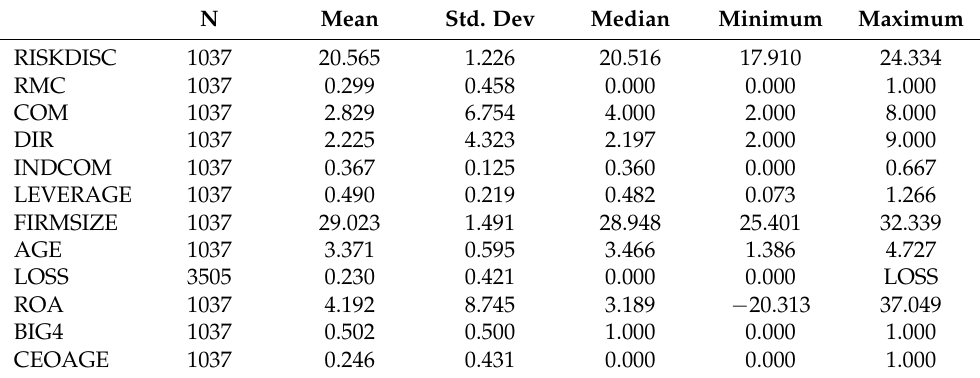
Table 3. Descriptive statistics.